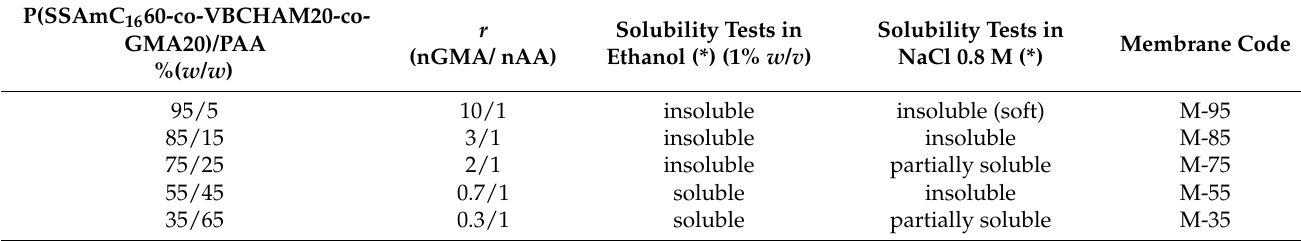
Table 1. Solubility tests of P(SSAmC 16 60-co-VBCHAM20-co-GMA20)/PAA membranes after curing at 120 °C.